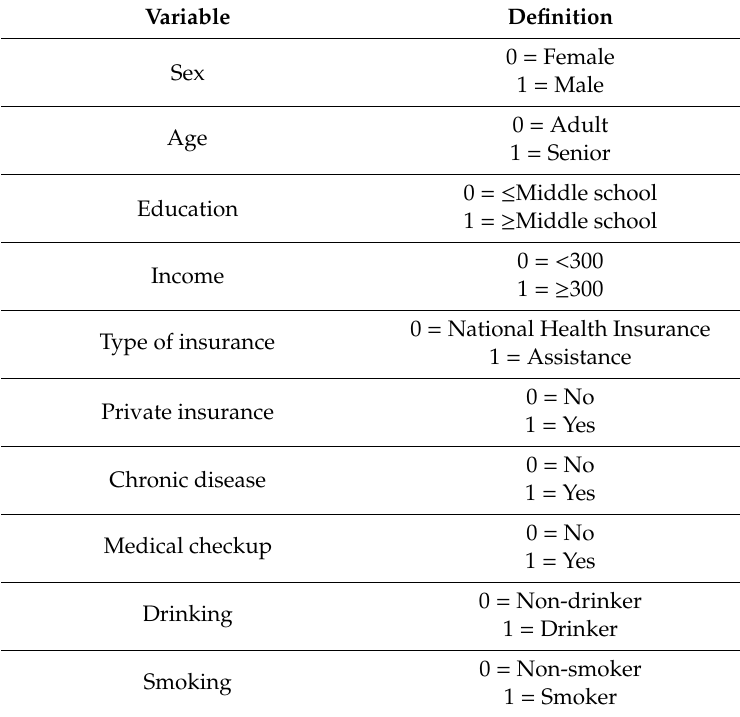
Table 1. Classification and definition of